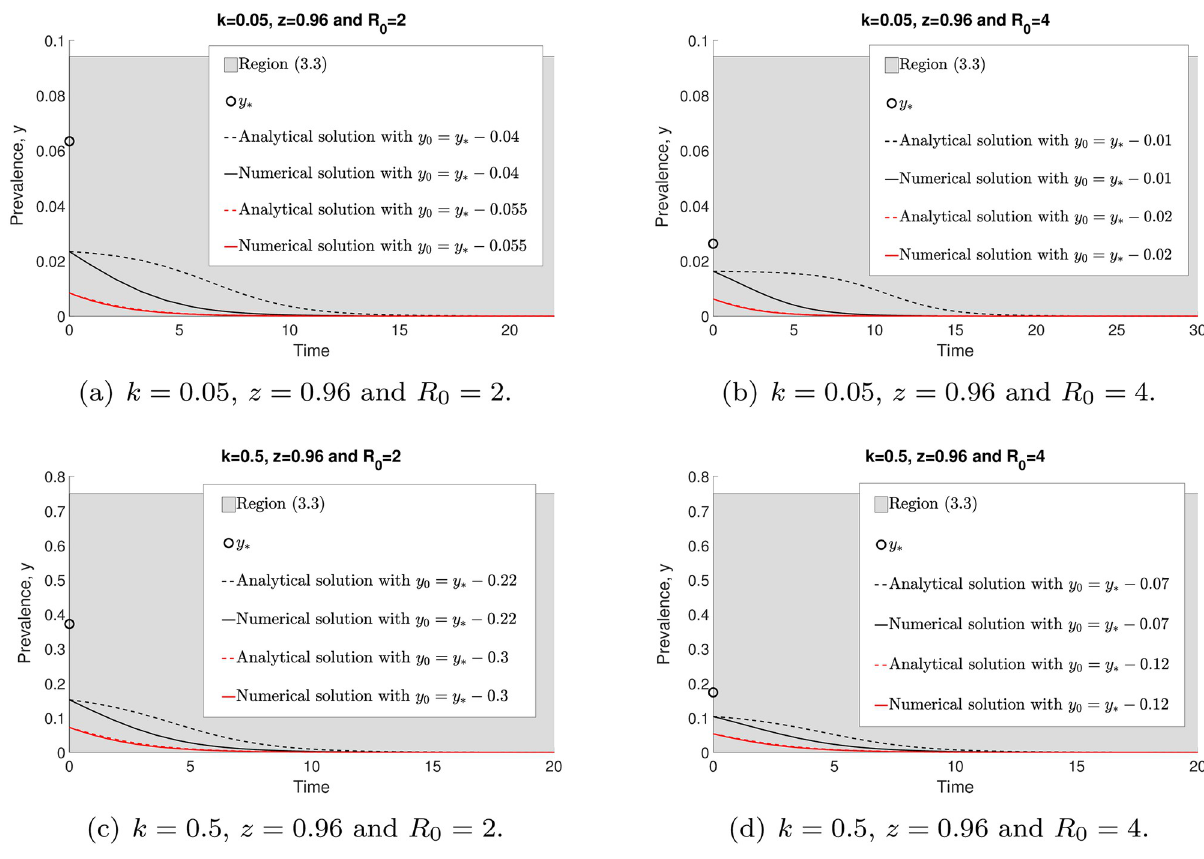
Fig 7. The comparisons of the analytical (9) and numerical (with approximations) (5) solutions with arbitrary initial points around y = 0 and y 0 < y �